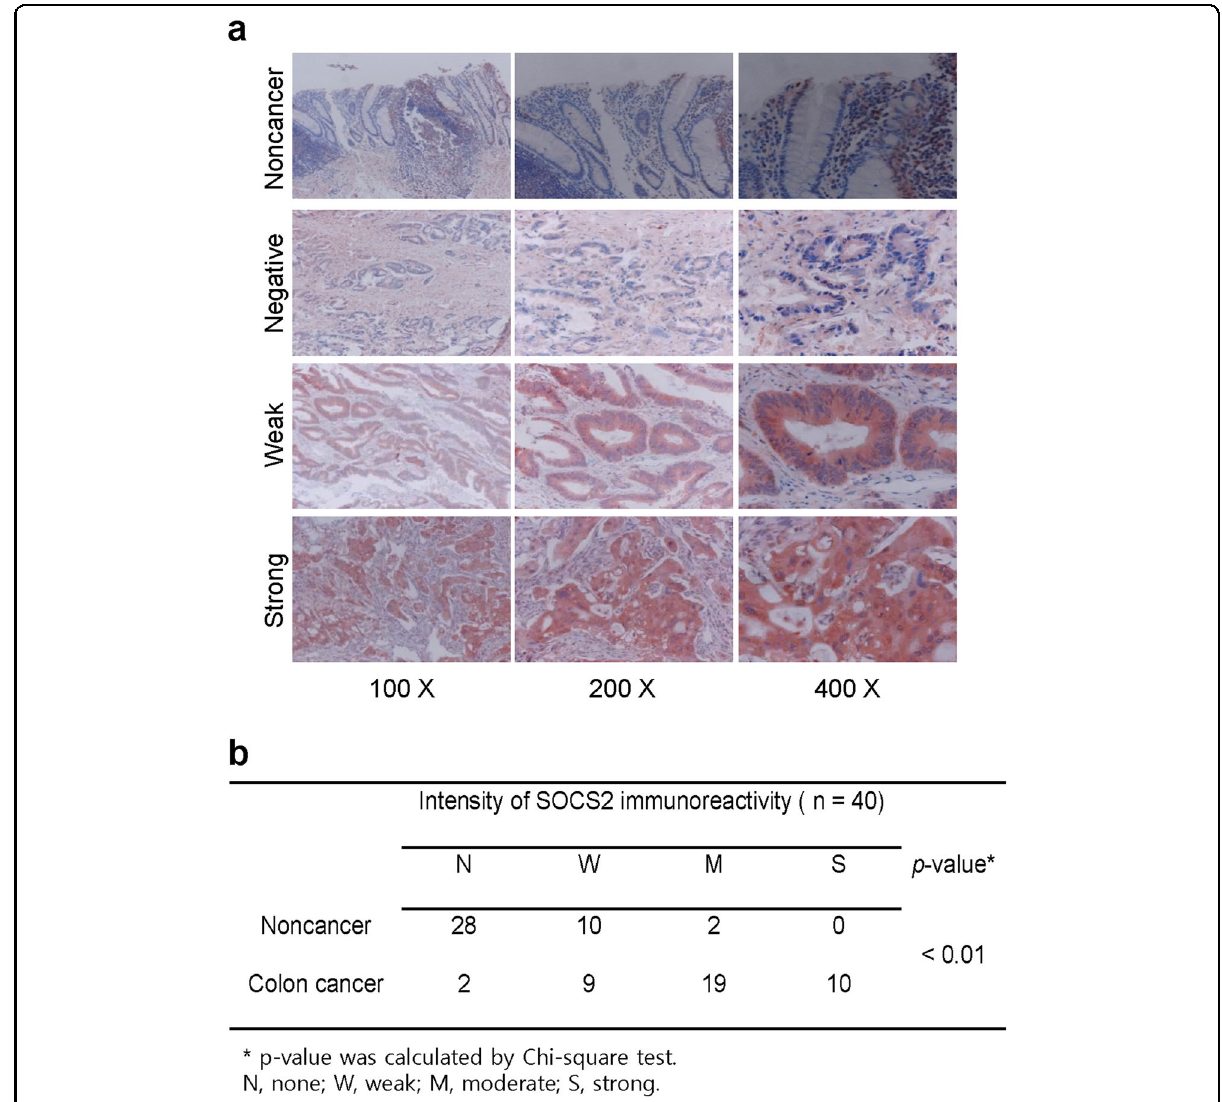
Fig. 5 Immunohistochemistry of colon cancer tissues and corresponding nontumor tissues. a Various SOCS2 expression was detected in colon cancer tissues compared with the corresponding nontumor tissues ( n = 40, P < 0.01). b Comparison of SOCS2 immunoreactivity between colon cancer (CC) tissues and noncancer (NC) tissues according to the intensity of